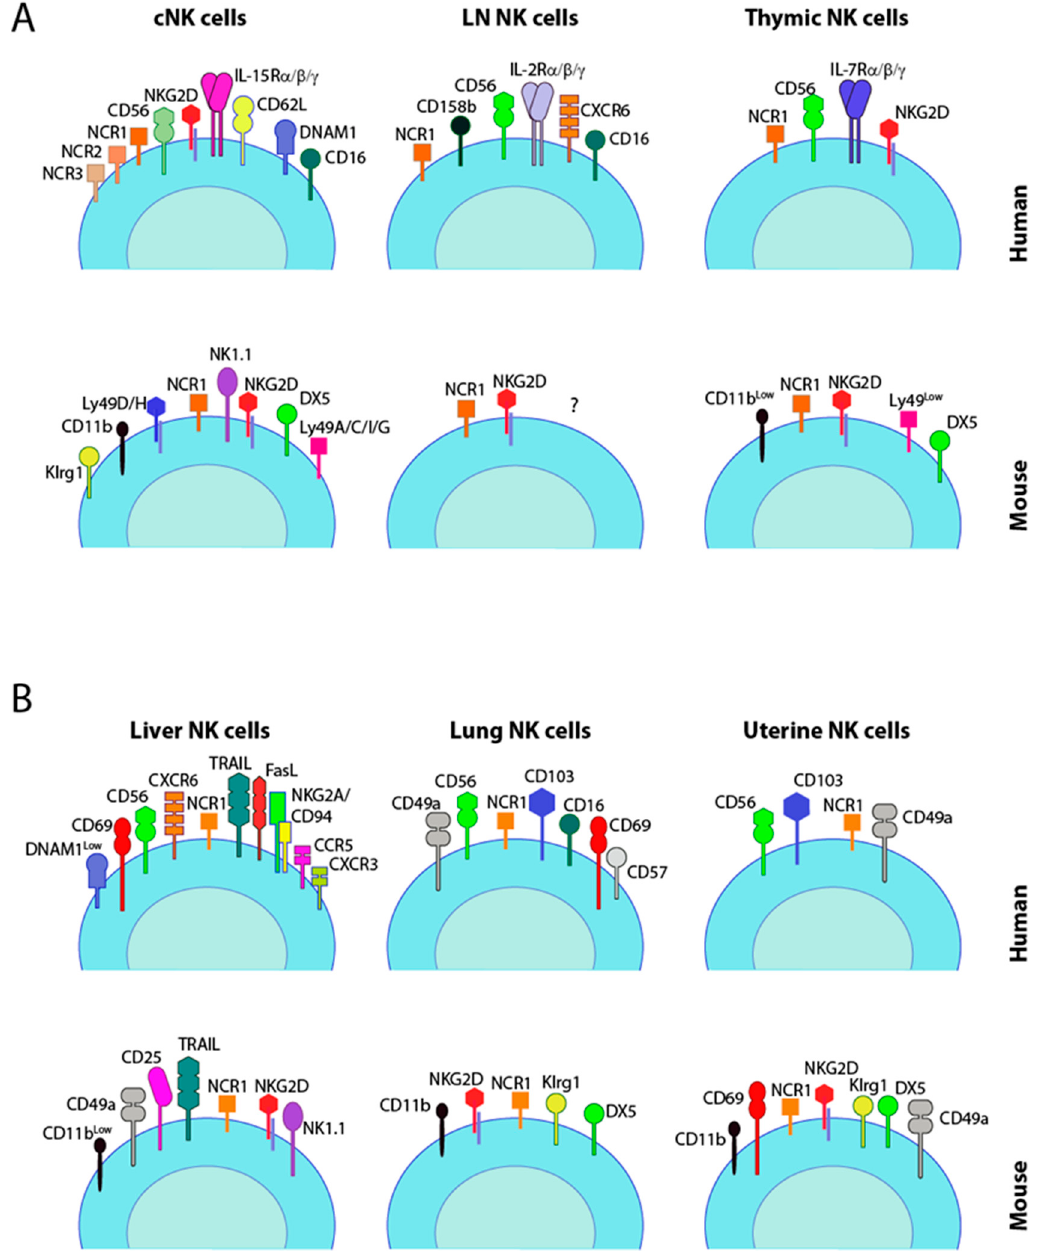
Figure 1. Phenotypic delineation of tissue-resident natural killer (trNK) cell subsets. Both human and mouse NK cells are shown. The surface markers of cNK cells from human blood or mice spleen are compared to the trNK cells from indicated tissues. ( A ) Conventional NK cells (cNK) are compared to lymph node (LN) and thymic NK cells. ( B ) Phenotypic markers of tissue-resident NK cells from the liver, lung, and uterus in humans and mice. CD56 is depicted in either bright green or light green to indicate the predominant presence of CD56 bright or CD56 dim subsets in the circulating conventional (cNK cells) or individual organs.